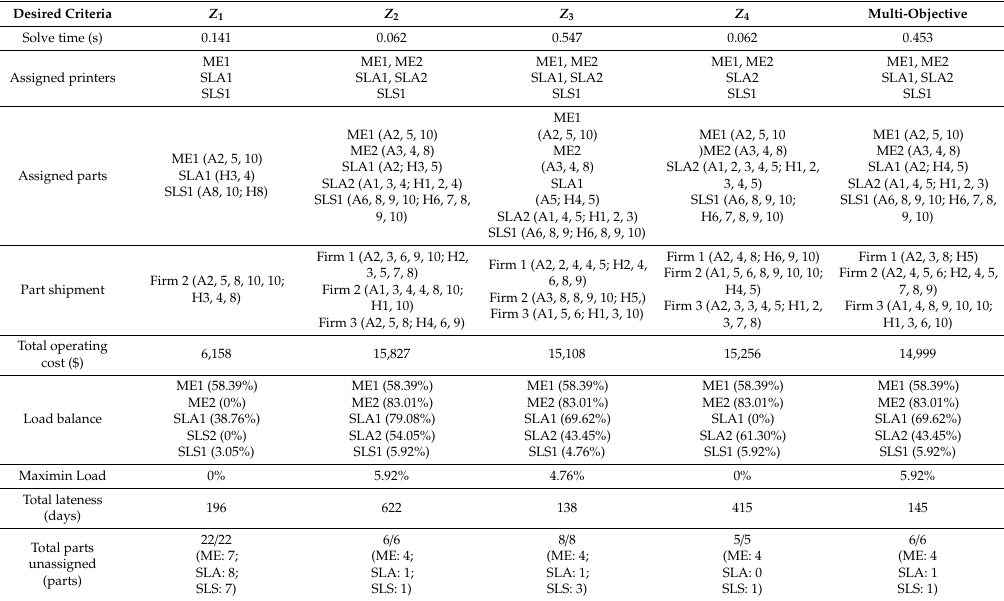
Table 5. Results of the case study based on each objective